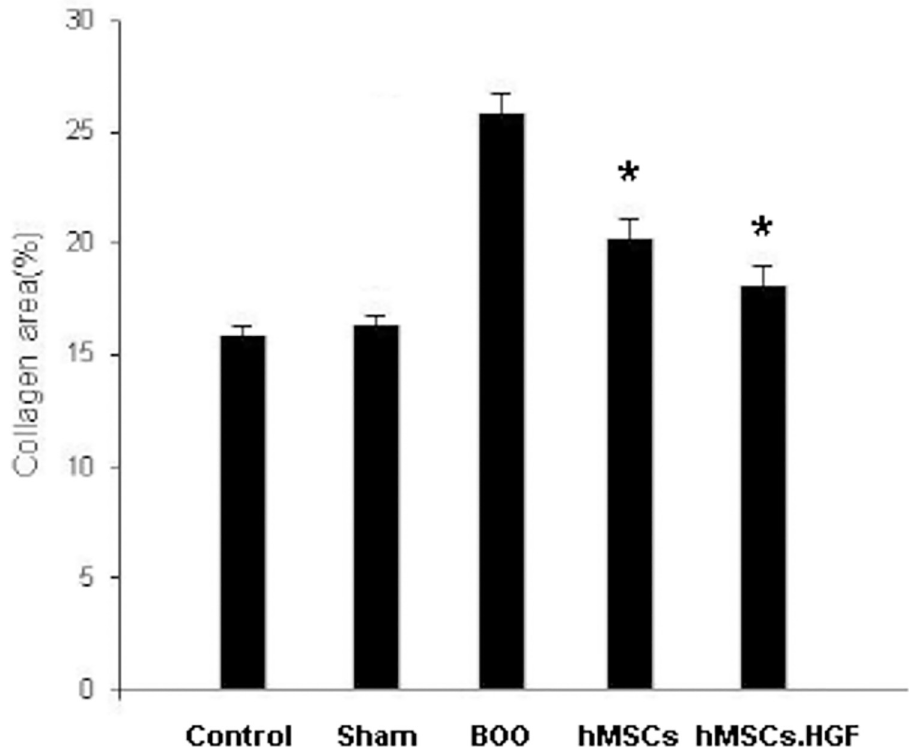
Fig 2. Percentage of collagen area. The group with BOO showed increased ratio of collagen to collagen + muscle (%) than the group with sham operation and control ( � p < 0.05). The group with BOO transplanted with hMSCs showed decreased ratio than the group with BOO. The effect was enhanced by HGF overexpression of hMSCs. Sham = sham operation, BOO = bladder outlet obstruction, hMSCs = human mesenchymal stem cells injection, hMSCs.HGF = HGF overexpressing human mesenchymal stem cells injection. � p <